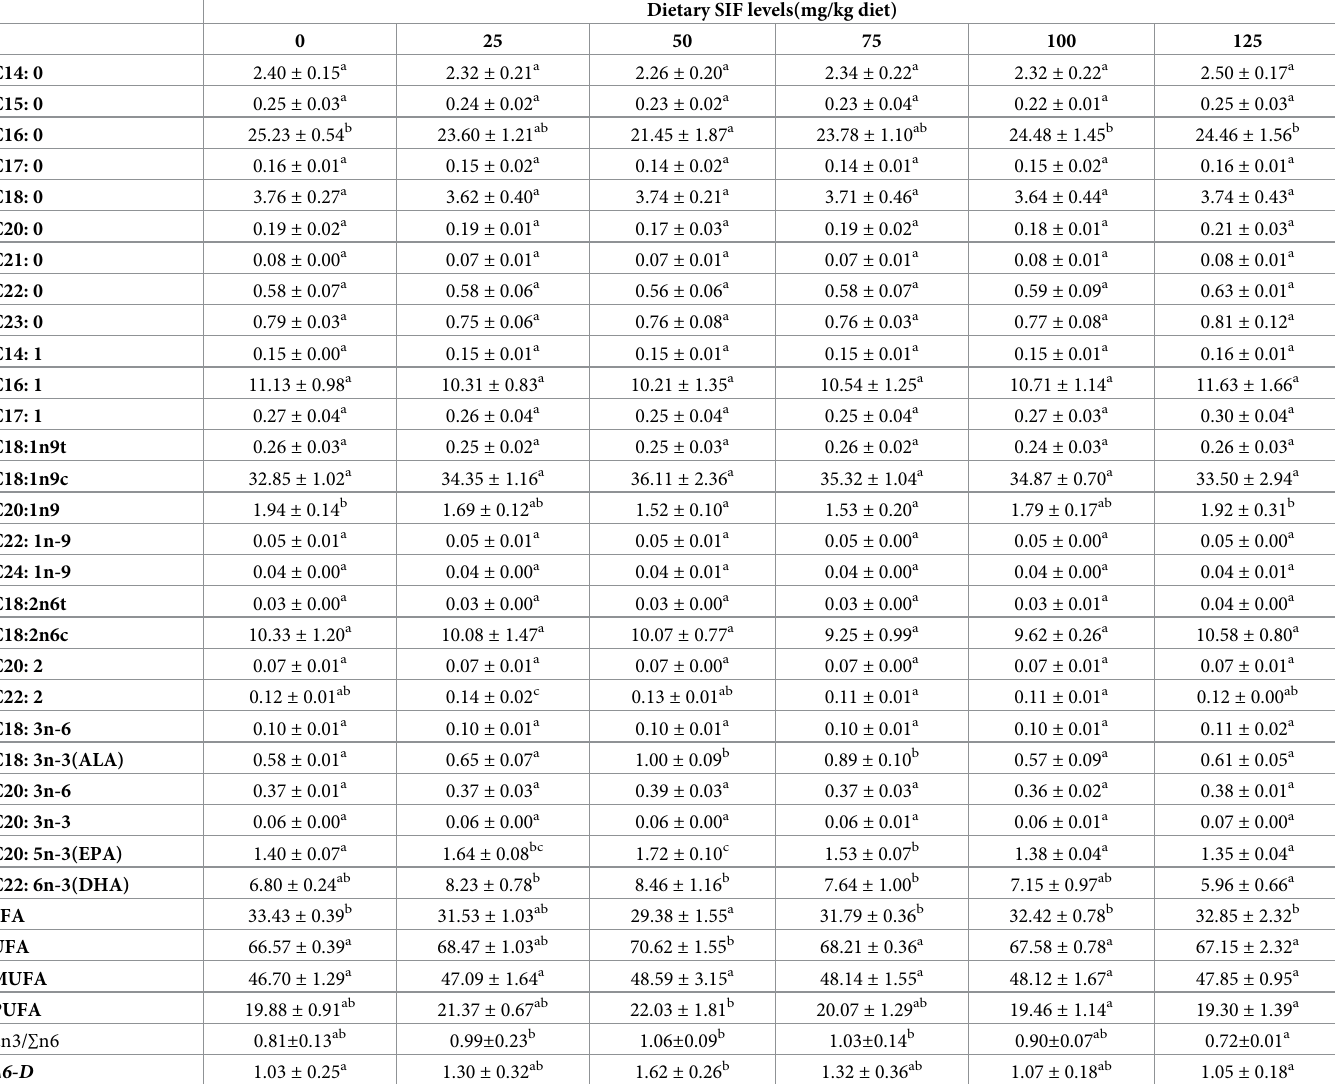
Table 4. Effects of dietary SIF supplementation (mg/kg) on muscle fillet fatty acid composition (% total fatty acids) and Δ 6-desaturase gene expression of grass carp 1 .